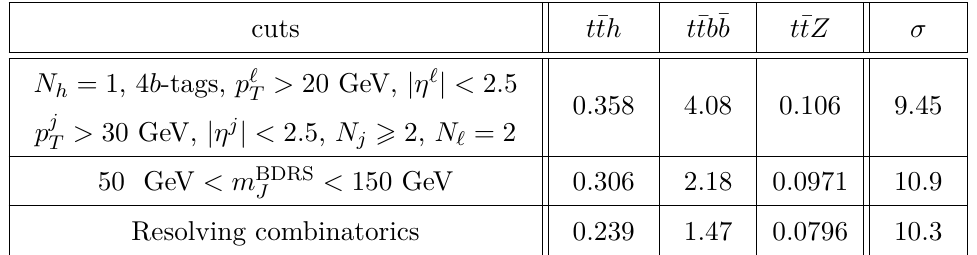
Cumulative cut-flow table showing cross-section in fb for t ¯ th signal ( κ t = 1 , α = 0 ) and leading backgrounds t ¯ tb ¯ b and t ¯ tZ at the 14 TeV LHC. Significances ( σ ) are calculated for a luminosity of 3 ab − 1 . We apply a flat b -tag rate of (cid:15) b → b = 0 . 85 and a light-jet ( c -jet) mistag rate of (cid:15) j → b = 0 . 01 ( (cid:15) c → b = 0 . 25 ) in accordance with the improvements reported by the ATLAS collaboration for the HL-LHC performance